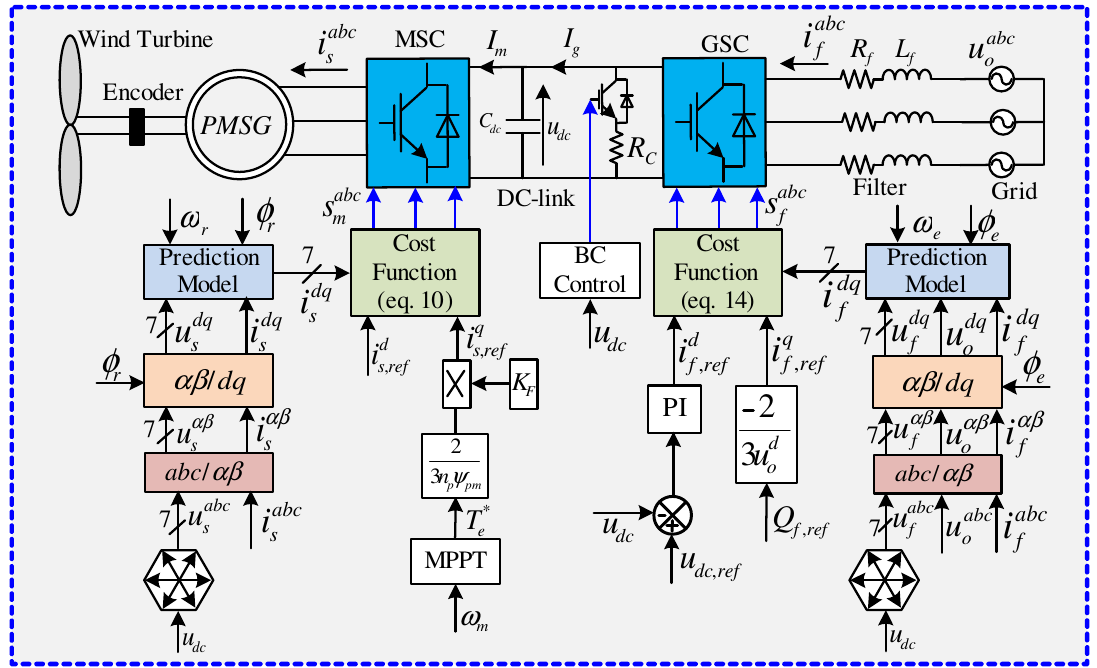
Figure 1. Proposed fault-ride through strategy for permanent-magnet synchronous generator-based wind